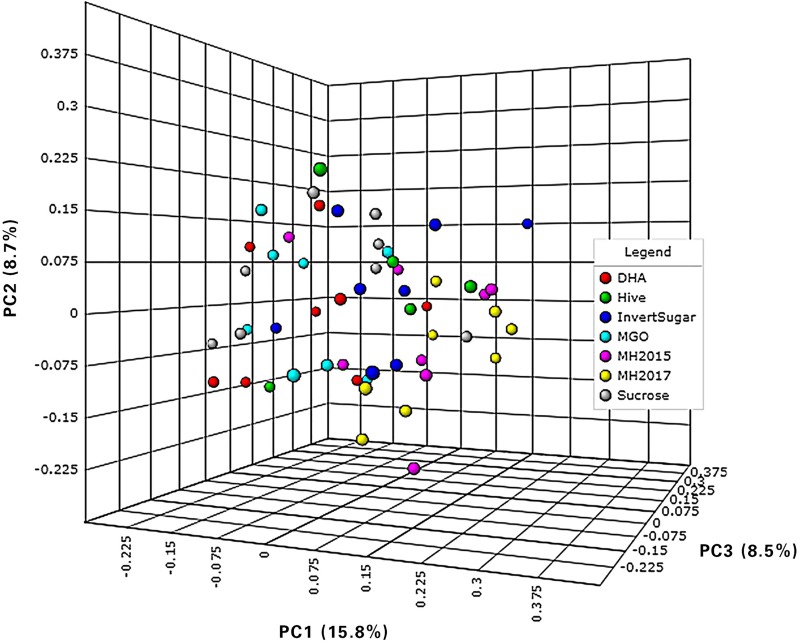
A principal co-ordinate analysis of the beta-diversity of OTUs within the gut of NZ honey bees. Honey bees from a single hive were fed one of seven carbohydrate diets for 6 days.